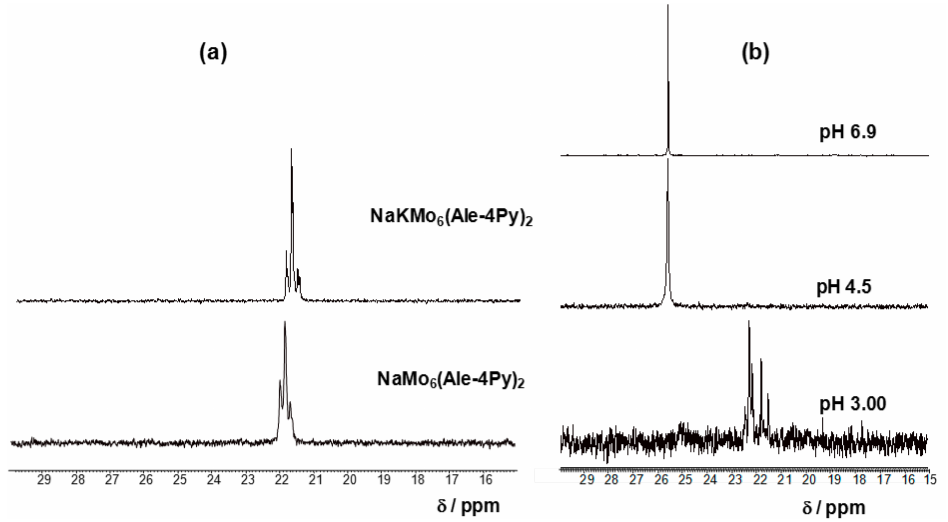
Figure 2. 31 P NMR spectra of a) the synthetic medium of NaMo 6 (Ale-4Py) 2 and NaKMo 6 (Ale-4Py) 2 and b) an aqueous solution of NH 4 Mo 6 (AlePy 2 Mo) 2 at various